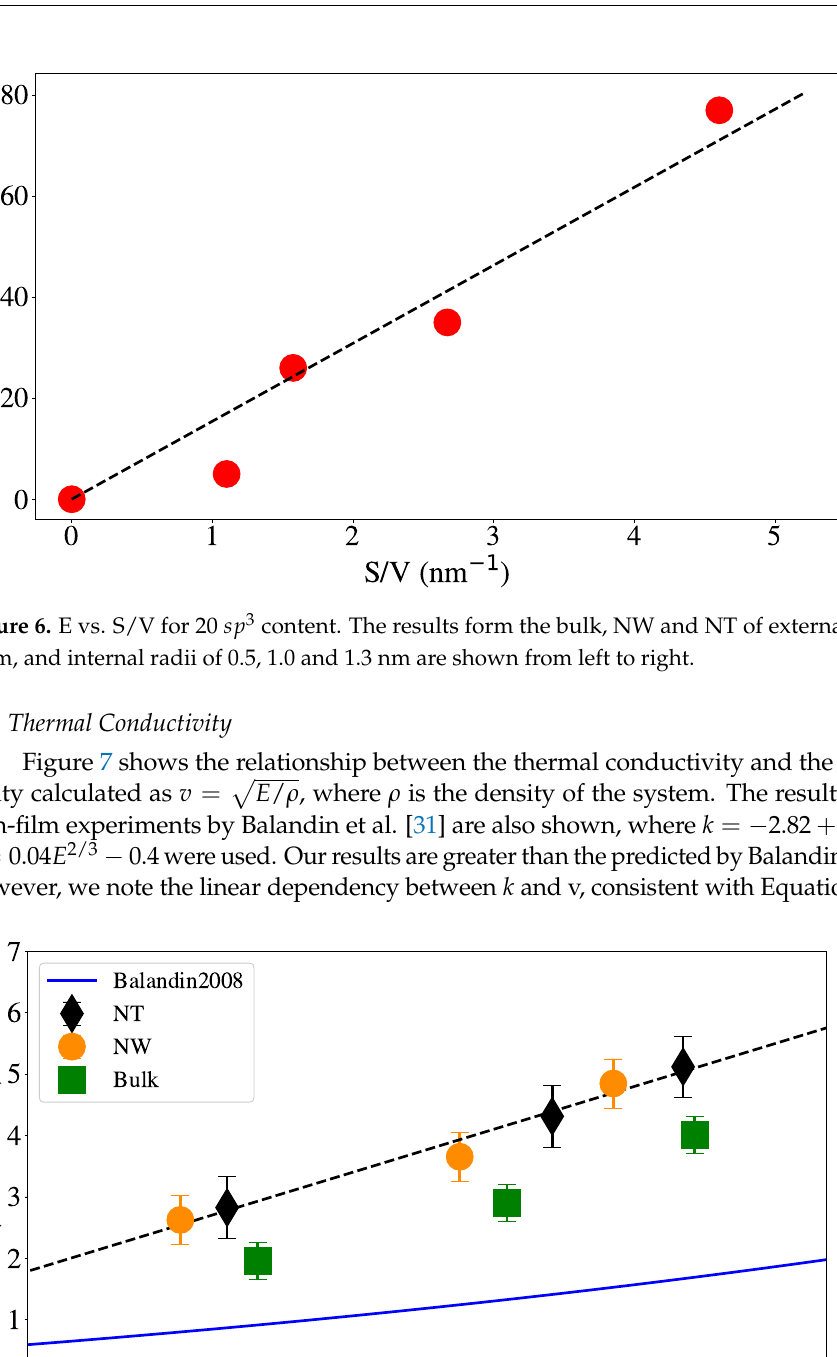
Figure 7. Thermal conductivity at 300 K vs. sound velocity v = internal radius is 1 nm). The solid line shows the fit obtained from aC thin-film experiments by Balandin et al. [31], where k = − 2.82 + 1.77 ρ and k = 0.04 E 2/3 − 0.4 were used. The dashed line shows a linear fit to our MD results, k = − 4.55 + 0.79 v